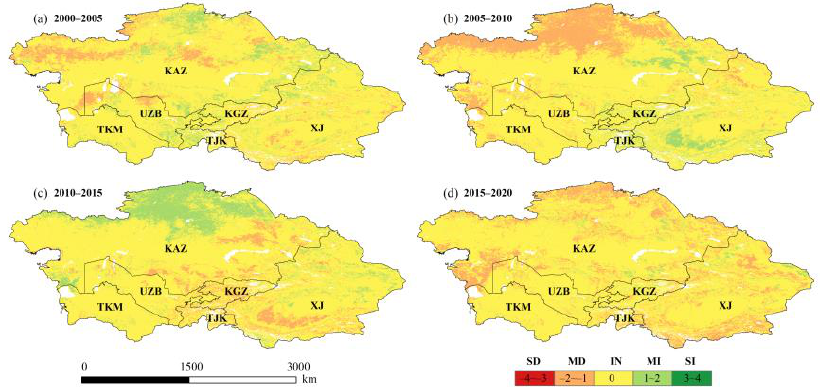
Figure 6. Spatial distribution of changes in the EEQ of CA and its six regions from 2000 to 2020 (SD, MD, IN, MI, and SI correspond to significant degeneration, mild degeneration, invariability, mild improvement, and significant improvement, respectively). Table 3. Spatial distribution of changes in the EEQ of CA and its six regions in various periods.